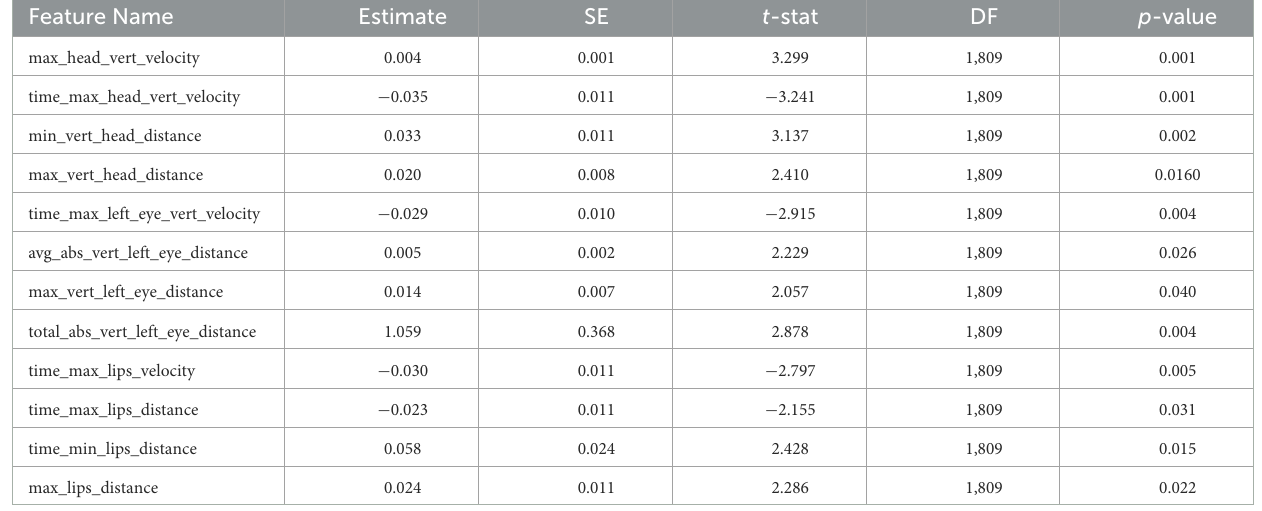
TABLE 2 Summary of the mixed-effects linear regression model for each of the features that involves a significant clear-plain difference across tones.